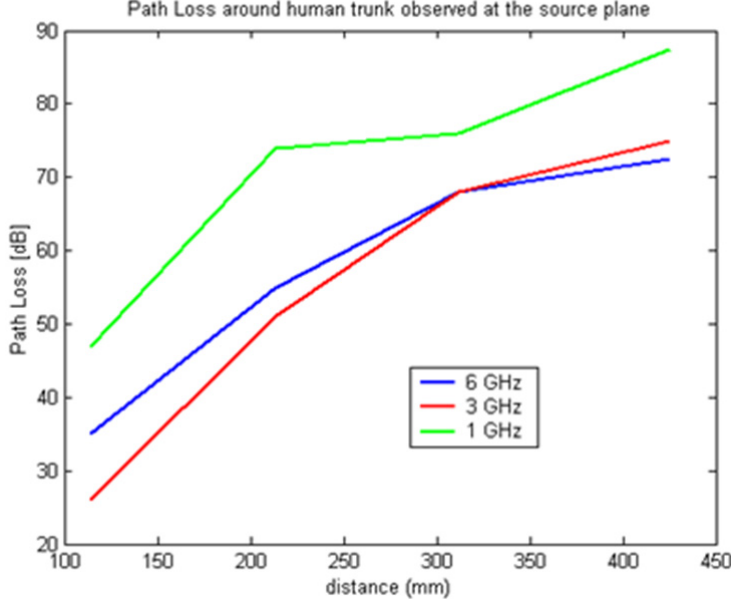
Figure 7. Path loss versus separation distance with receiving antenna at the source plane.